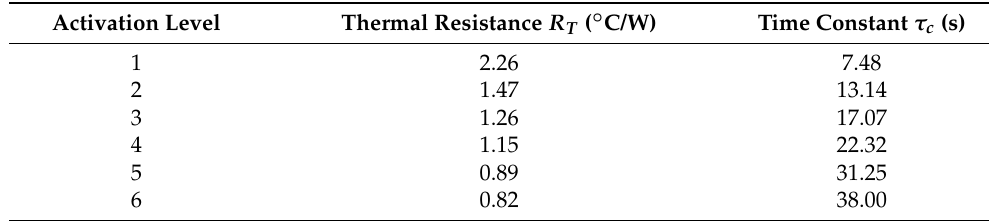
Table 7. Thermal resistances and time constants of the system for each activation level, calculated from experimental data. With each additional pair of TCAs, the thermal resistance decreased due the additional surface area, which increased the active portion of the actuator’s heat loss